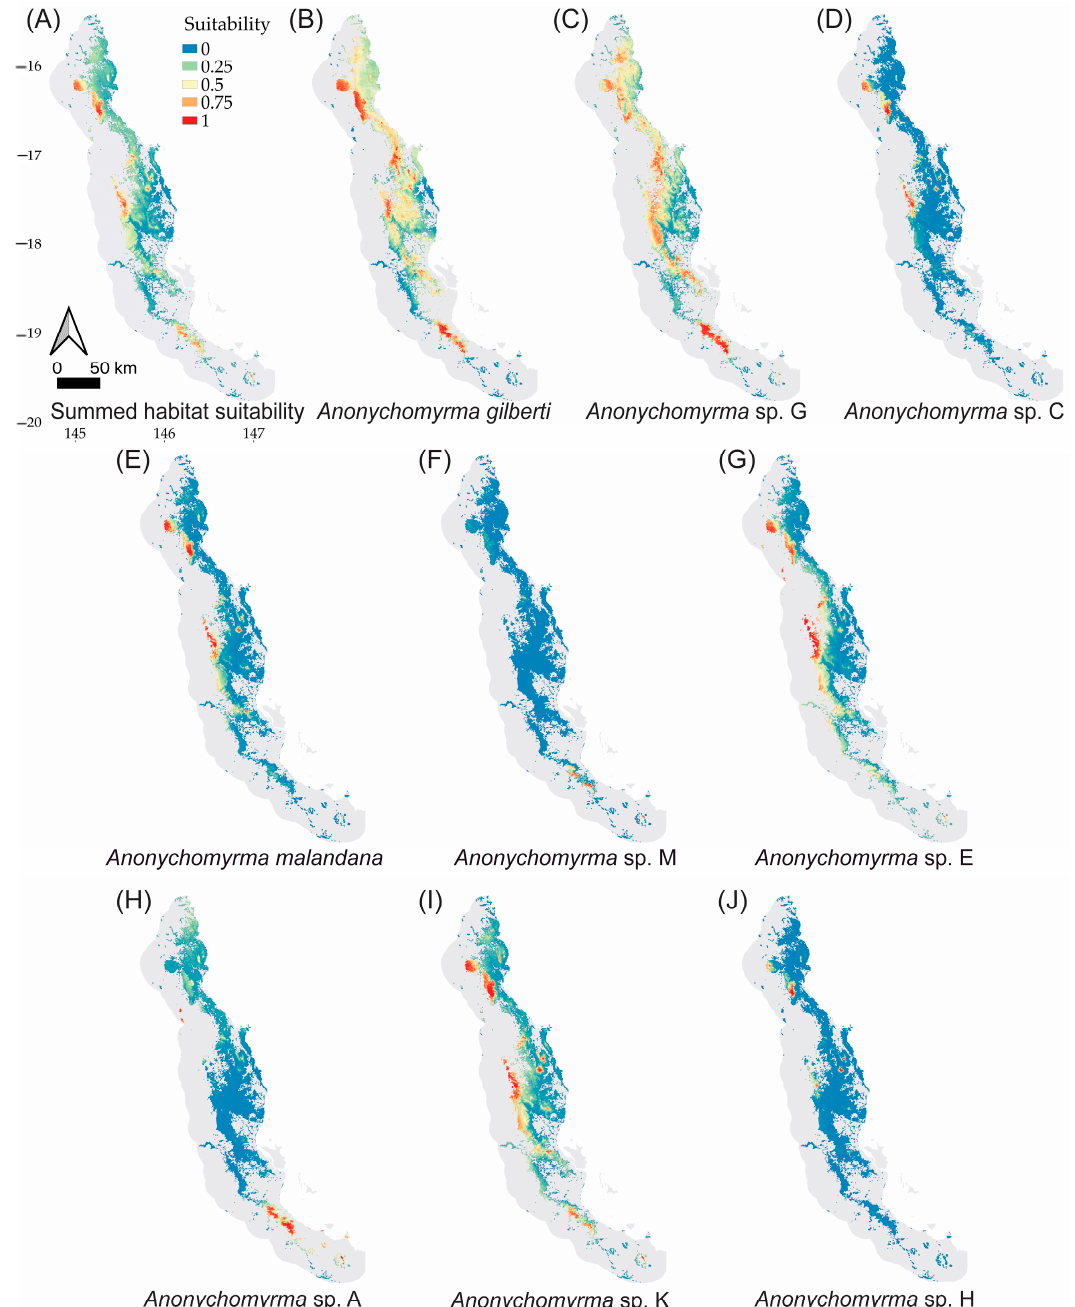
Figure 15. ( A ) Summed rainforest habitat suitability across all species in a grid cell based on the MaxEnt species distribution model for each species. ( B – J ) Modelled rainforest distributions for nine species of Anonychomyrma showing habitat suitability in the AWT bioregion. In all figures, blue is low habitat suitability, red is high habitat suitability, and grey background is the outline of the AWT region.